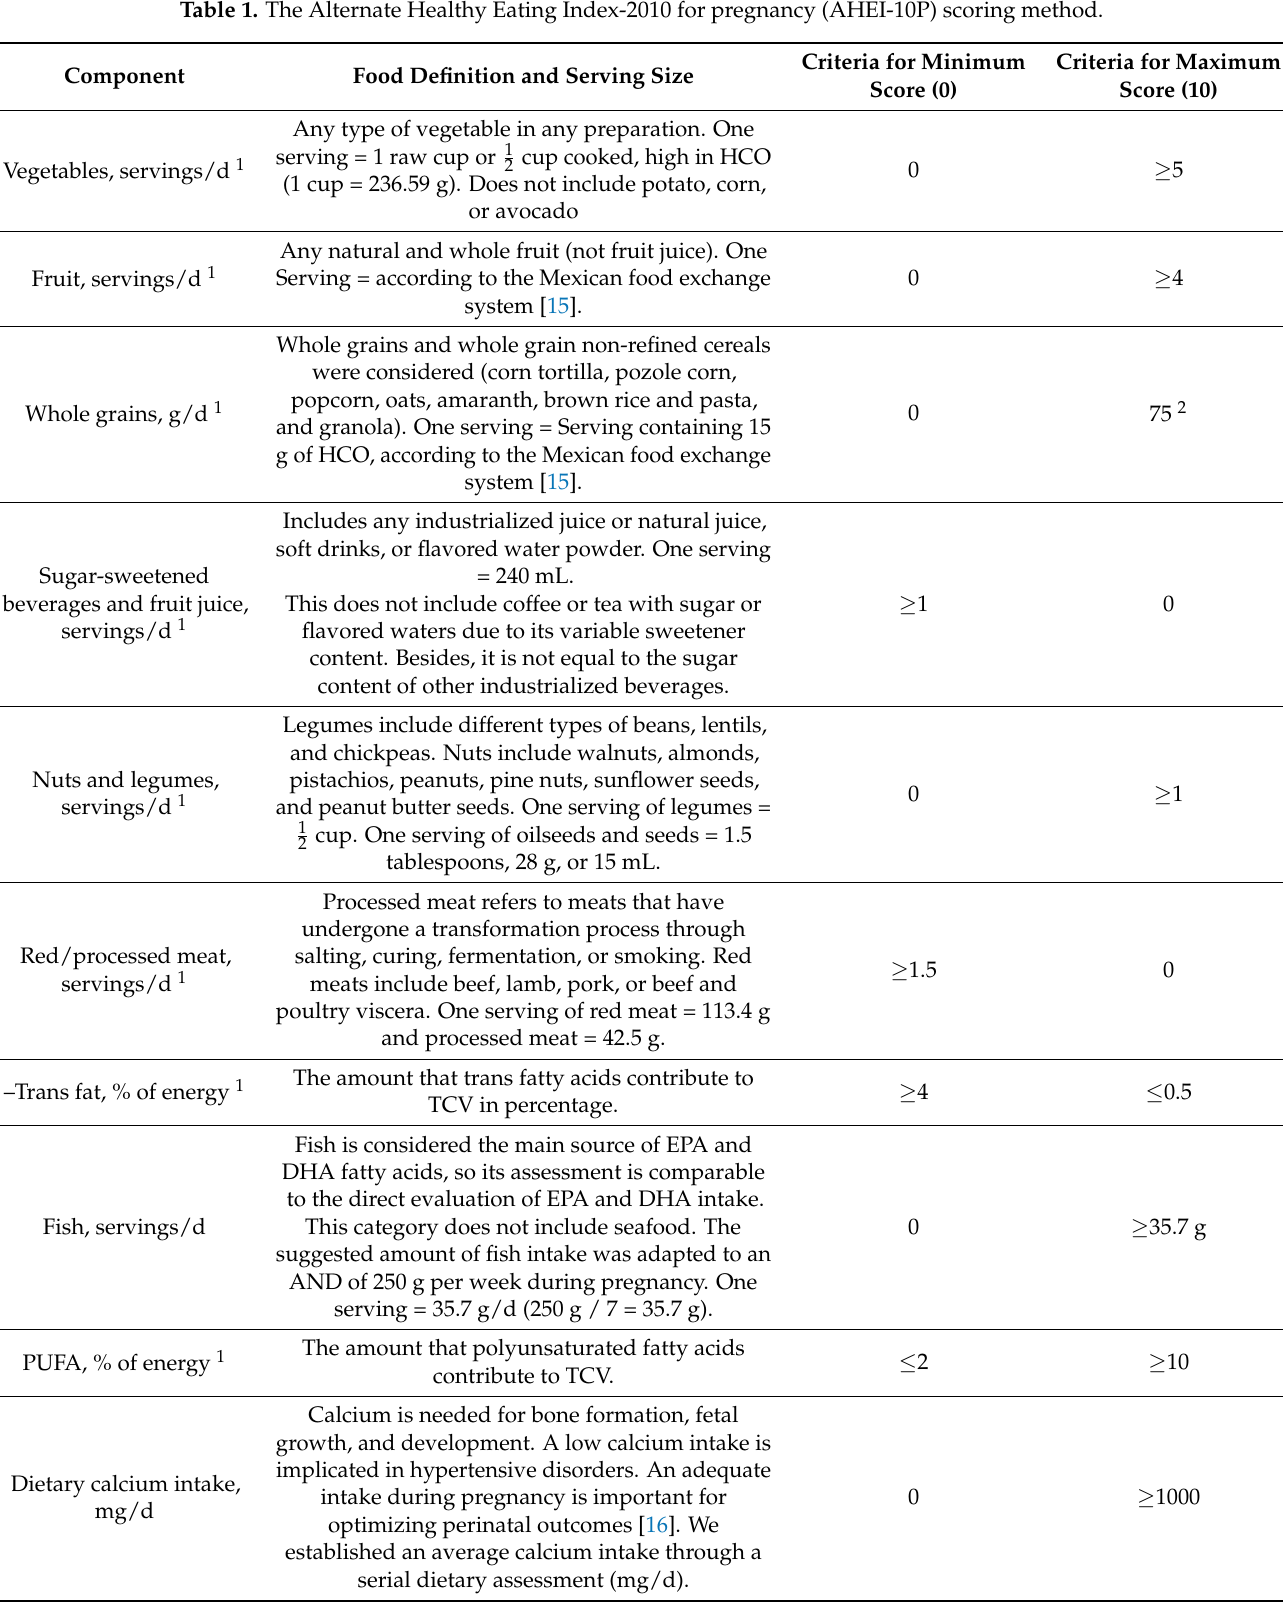
Table 1. The Alternate Healthy Eating Index-2010 for pregnancy (AHEI-10P) scoring